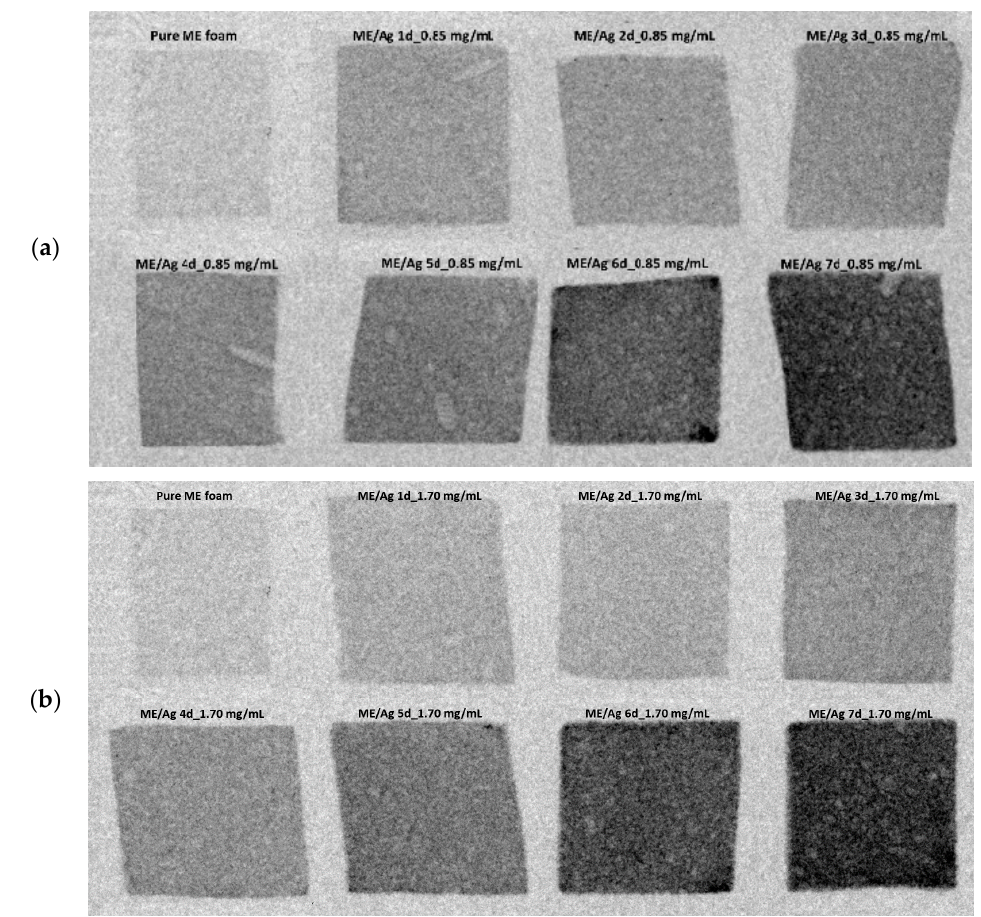
Figure 7. X-ray radioscopy of the untreated ME (pure) and functionalized ME/Ag using 0.85 mg/mL ( a ) and 1.70 mg/mL ( b ) as solution precursor for different reaction times from 1 to 7 days.